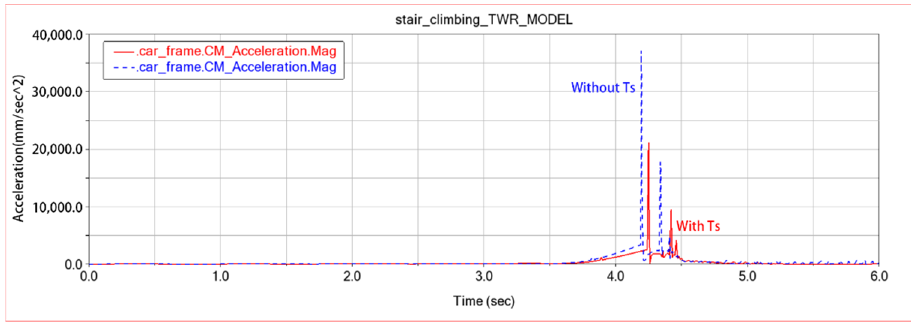
Figure 12. The acceleration of the frame centroid before and after adding T S .